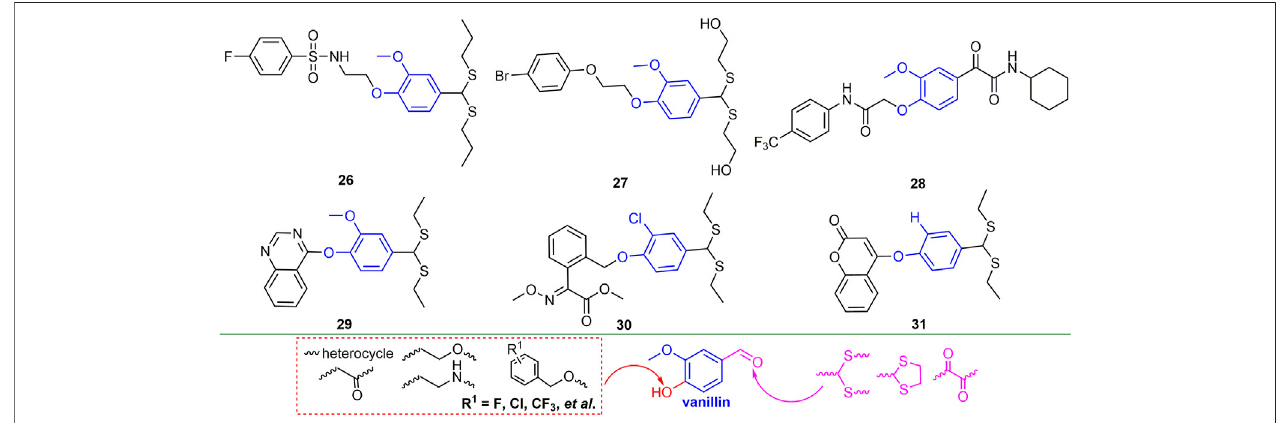
FIGURE 8 | Structures of representative vanillin derivatives in antiviral